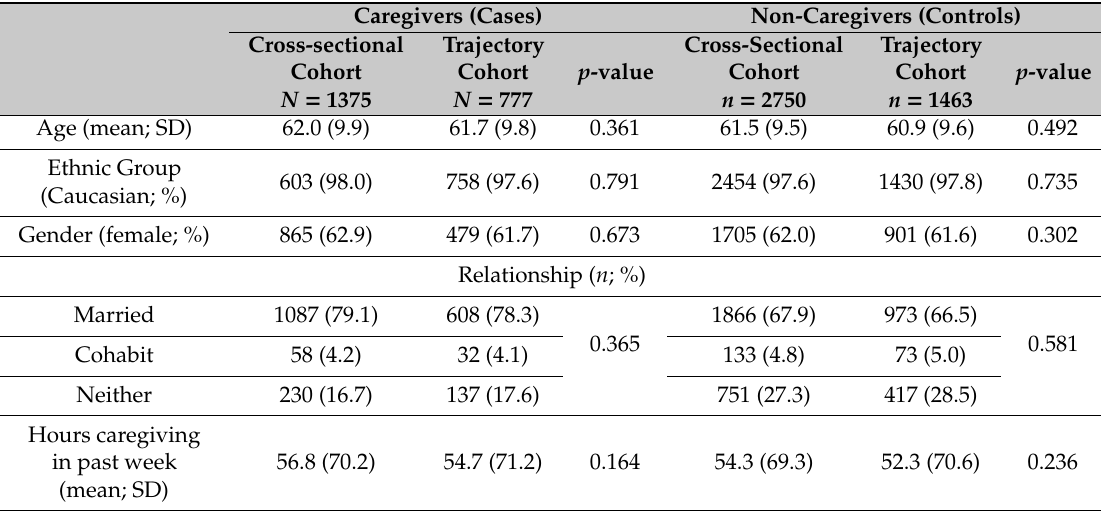
Table 4. Presentation of basic demographic characteristics for cross-section cohort and trajectory cohort characteristics for caregiver and non-caregiver